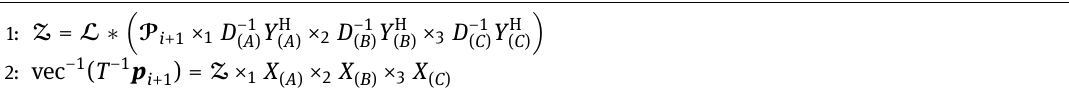
) using the eigendecomposition i +1